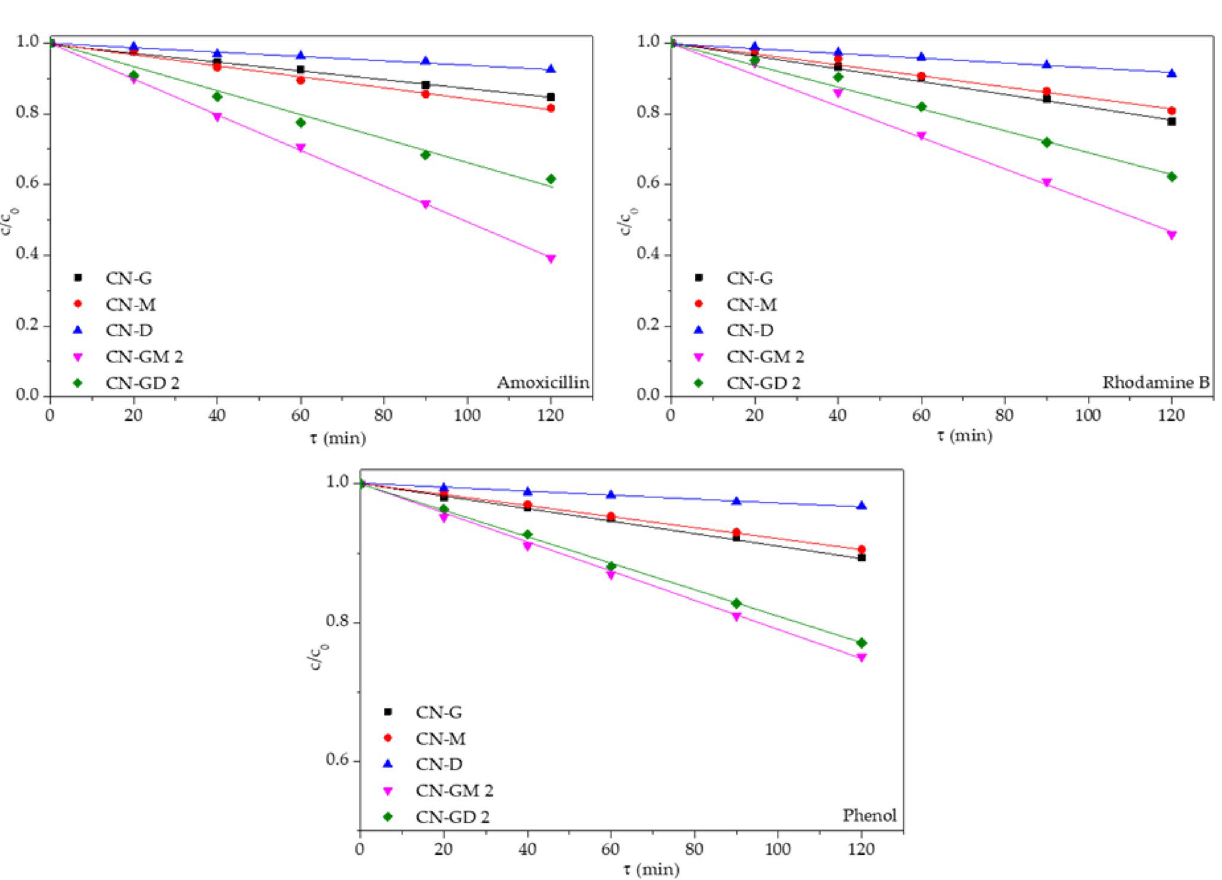
Figure 5. Kinetics curves of photocatalytic degradation of amoxicillin, RhB and phenol (CN-G, CN-M, CN-D, CN-GM 2 and CG-GD 2) (The LED irradiation of 420 nm and the intensity of 7.1 mW cm −2 ). The photocatalysts concentration was 0.3 g L −1